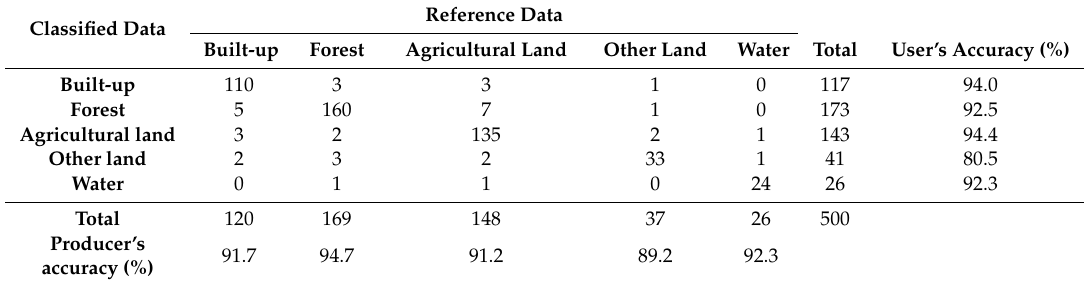
Table A3. Error matrix for the classified 1996 land use / cover